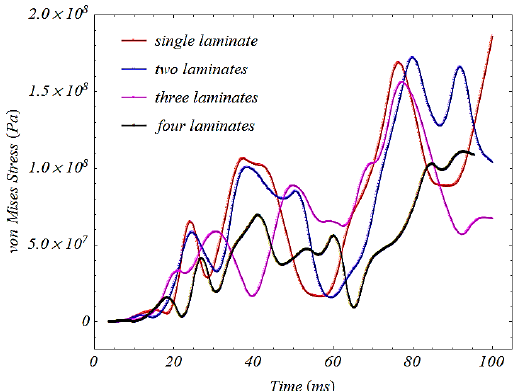
Fig. 17. von Mises stress against time for various number of cellphone casing laminates at 1000 mm drop